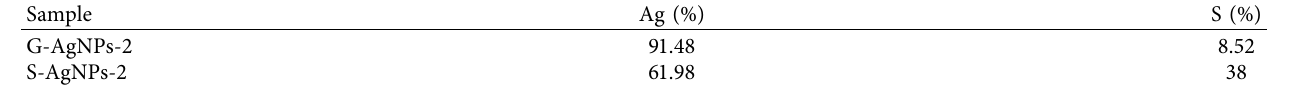
Table 3: Elemental composition of EDS analysis showed in Figures 5(c) and 5(d) (wt.%).